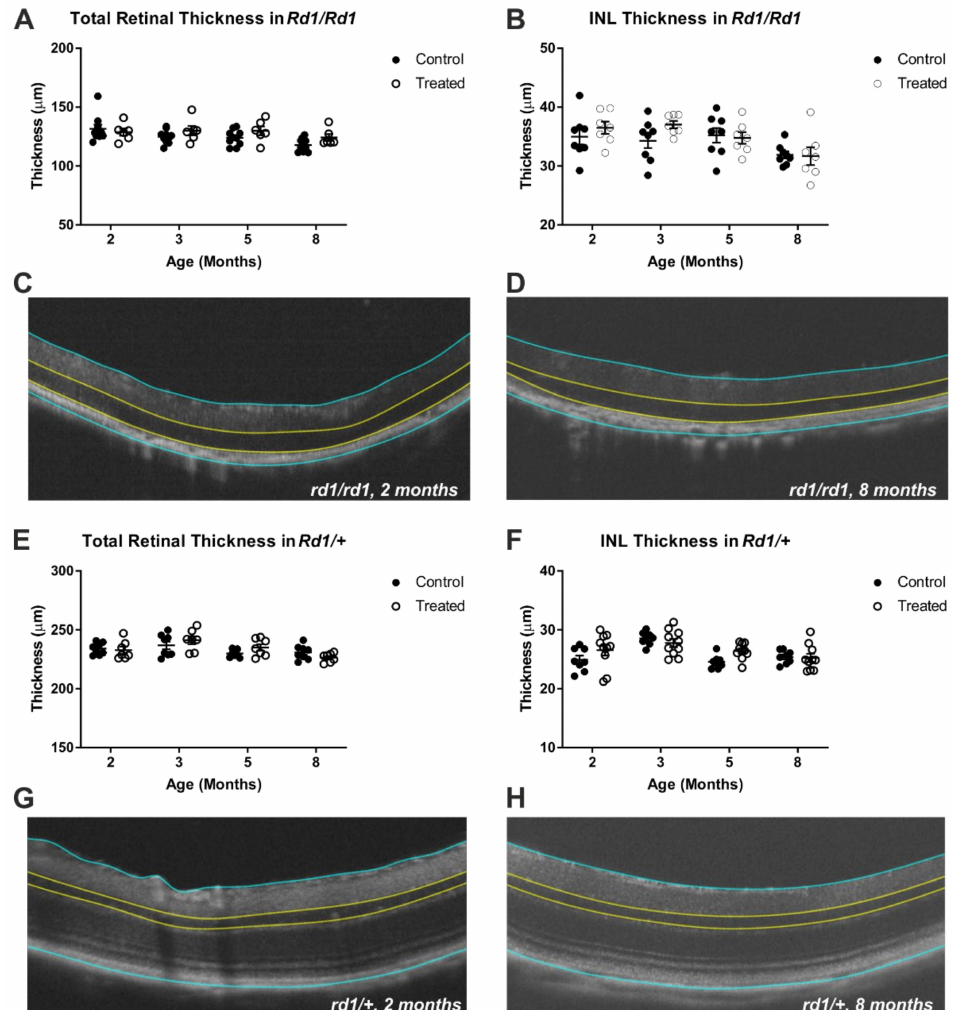
Figure 2. Longitudinal study of retinal thickness in a Grm6 Cre Rd1 mouse treated with human rod opsin. Total retinal thickness ( A ) and INL thickness ( B ) in rod opsin-treated and control mice